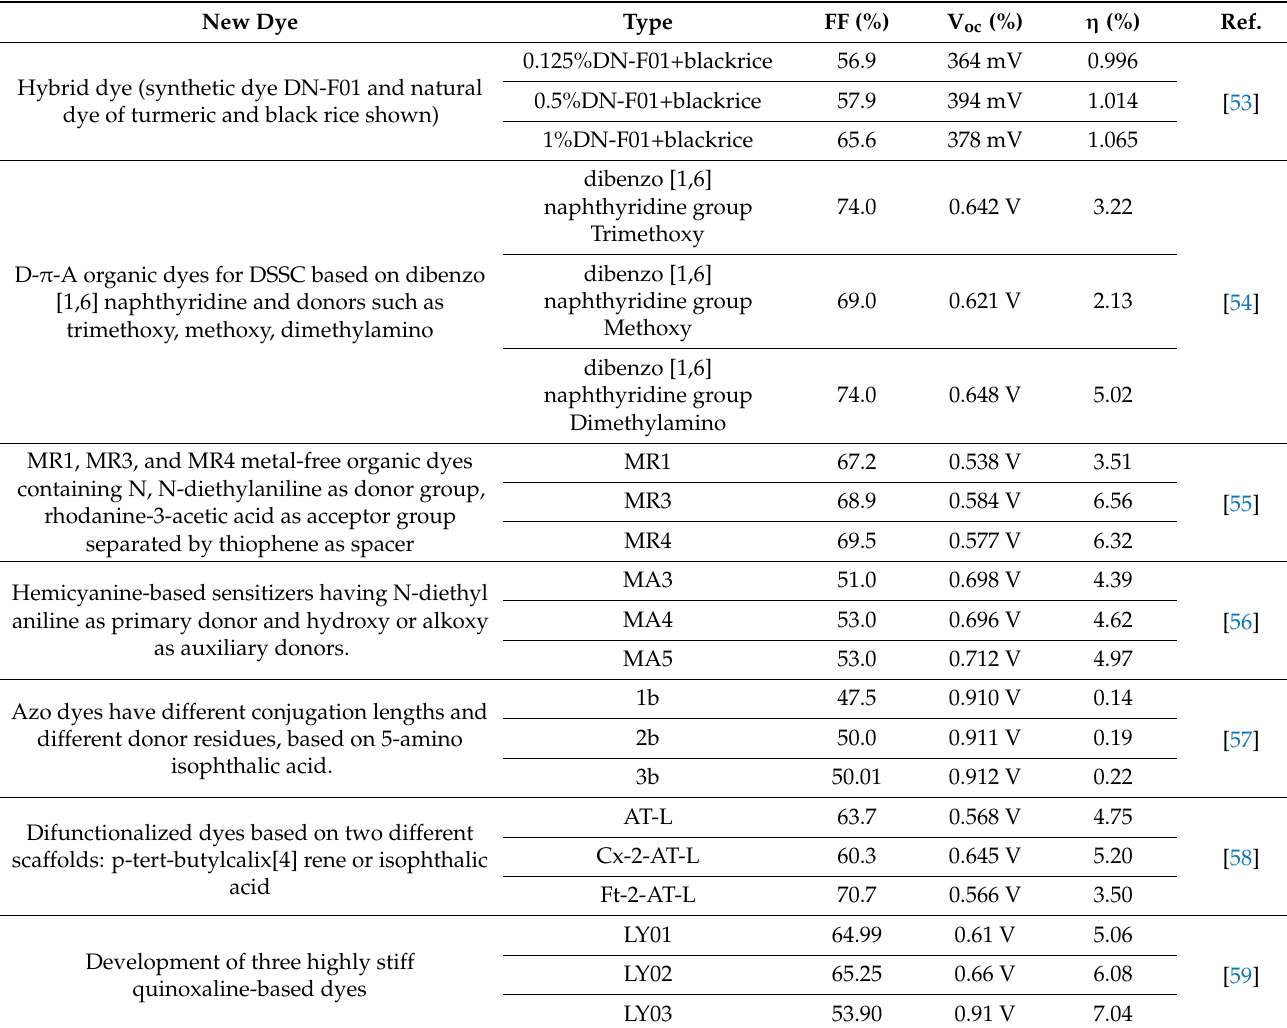
Table 3. New dyes for